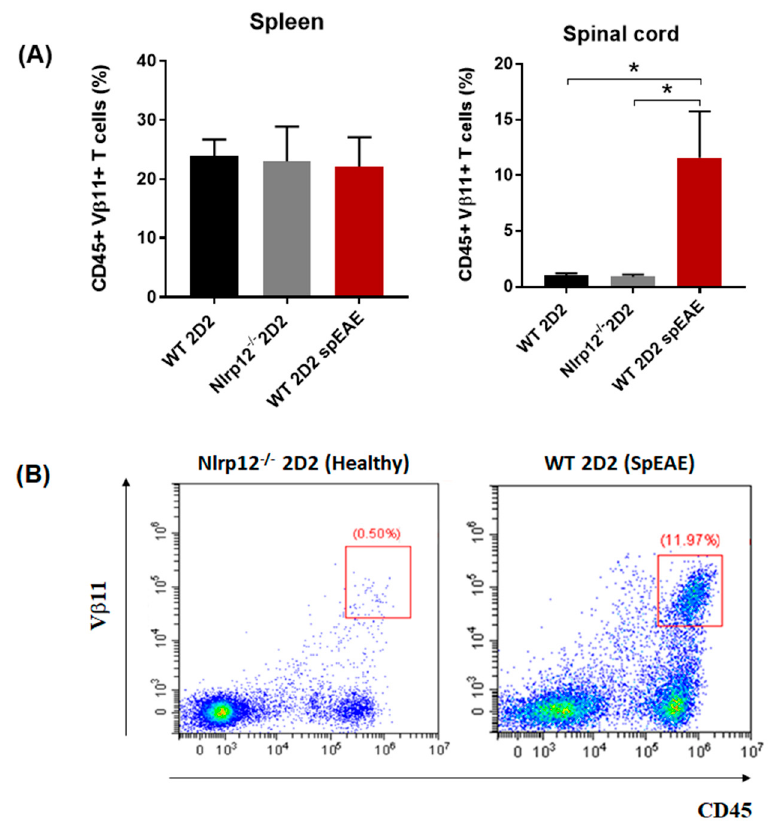
Figure 9. Myelin-specific T cells infiltrate to the spinal cord of spEAE mice. ( A ) The percentage of T cells expressing myelin-specific transgenic TCR (V β 11 + ) were comparable in the spleen of healthy and spEAE mice, however, the percentage of V β 11 + T cells were increased in the spinal cord of spEAE mice compared to WT healthy and Nlrp12 − / − healthy mice ( n = 6), * p < 0.05; ( B ) Representative flow cytometry plots of CD45 + V β 11 + T cells in the spinal cord of Nlrp12 − / − 2D2 healthy and WT 2D2 spEAE mice. Table 1. Nlrp12 does not prevent the development of spEAE. None of Nlrp12 − / − 2D2 mice developed spEAE, while 6 WT 2D2 mice out of 101 developed spEAE, manifested with ascending paralysis. Nlrp12 − / − 2D2 mice were monitored for 16 weeks and no sign of classical EAE was observed. Genotype Total ( n )